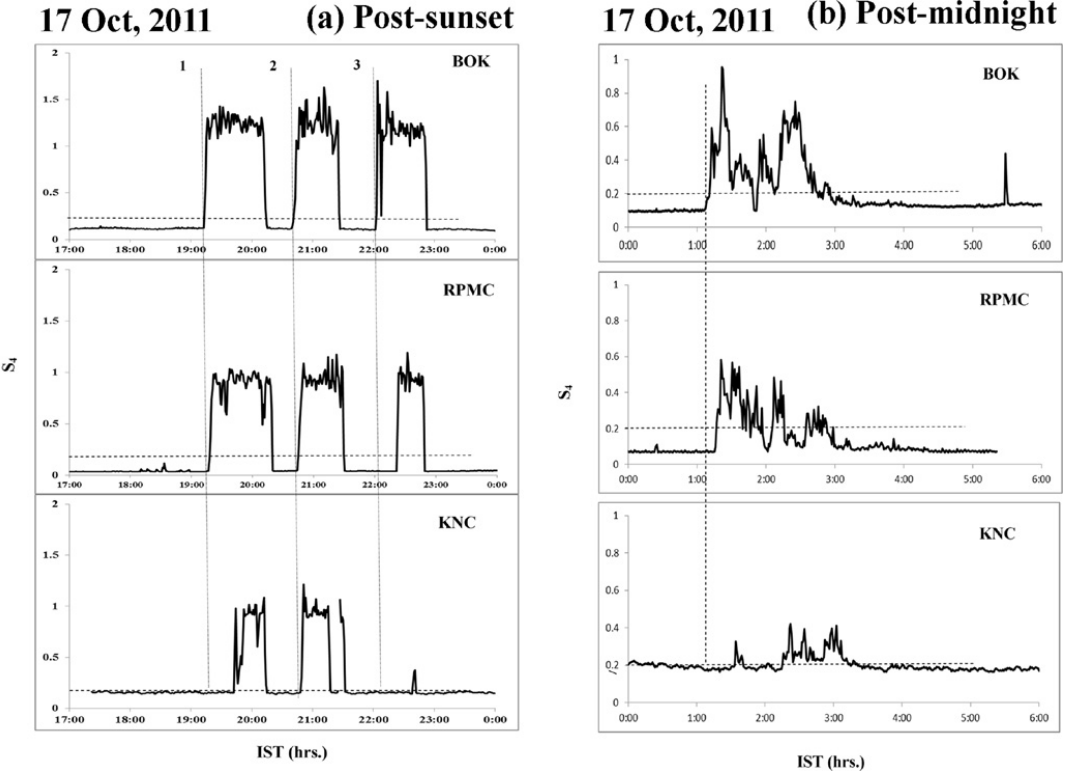
Fig. 3. Temporal variation of S 4 indices at VHF (250 MHz) as observed from BOK (uppermost panel), RPMC (middle panel) and KNC (lowest panel) during (a) post-sunset and (b) post-midnight period on 17 October 2011. The horizontal dotted line in the plot corresponds to S 4 ≈ 0 .